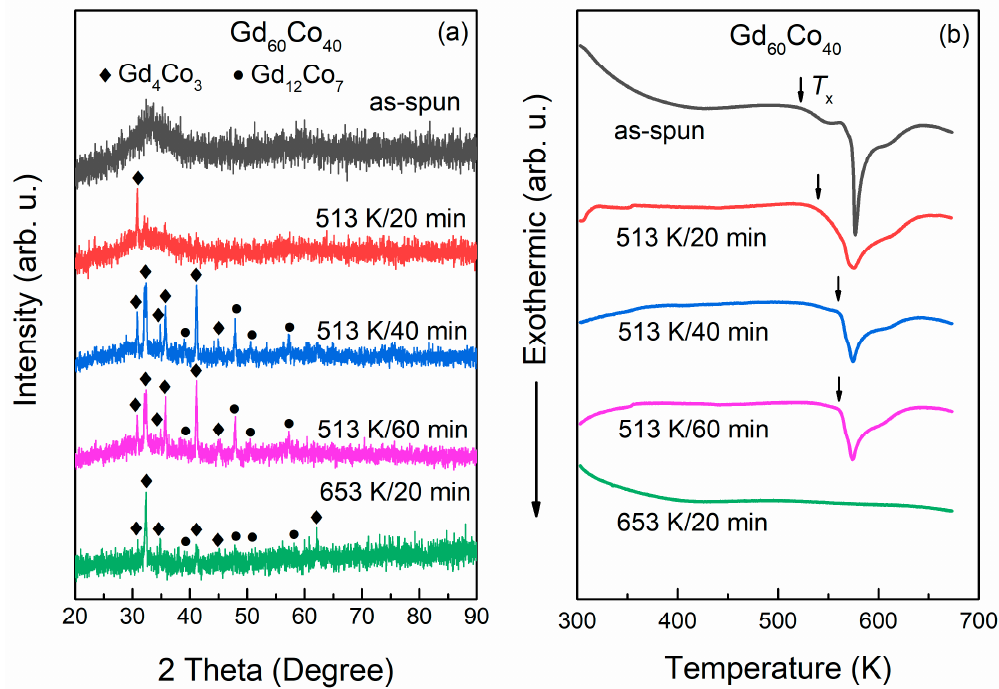
Figure 1. ( a ) XRD patterns and ( b ) DSC curves of as-spun and annealed Gd 60 Co 40 ribbons.